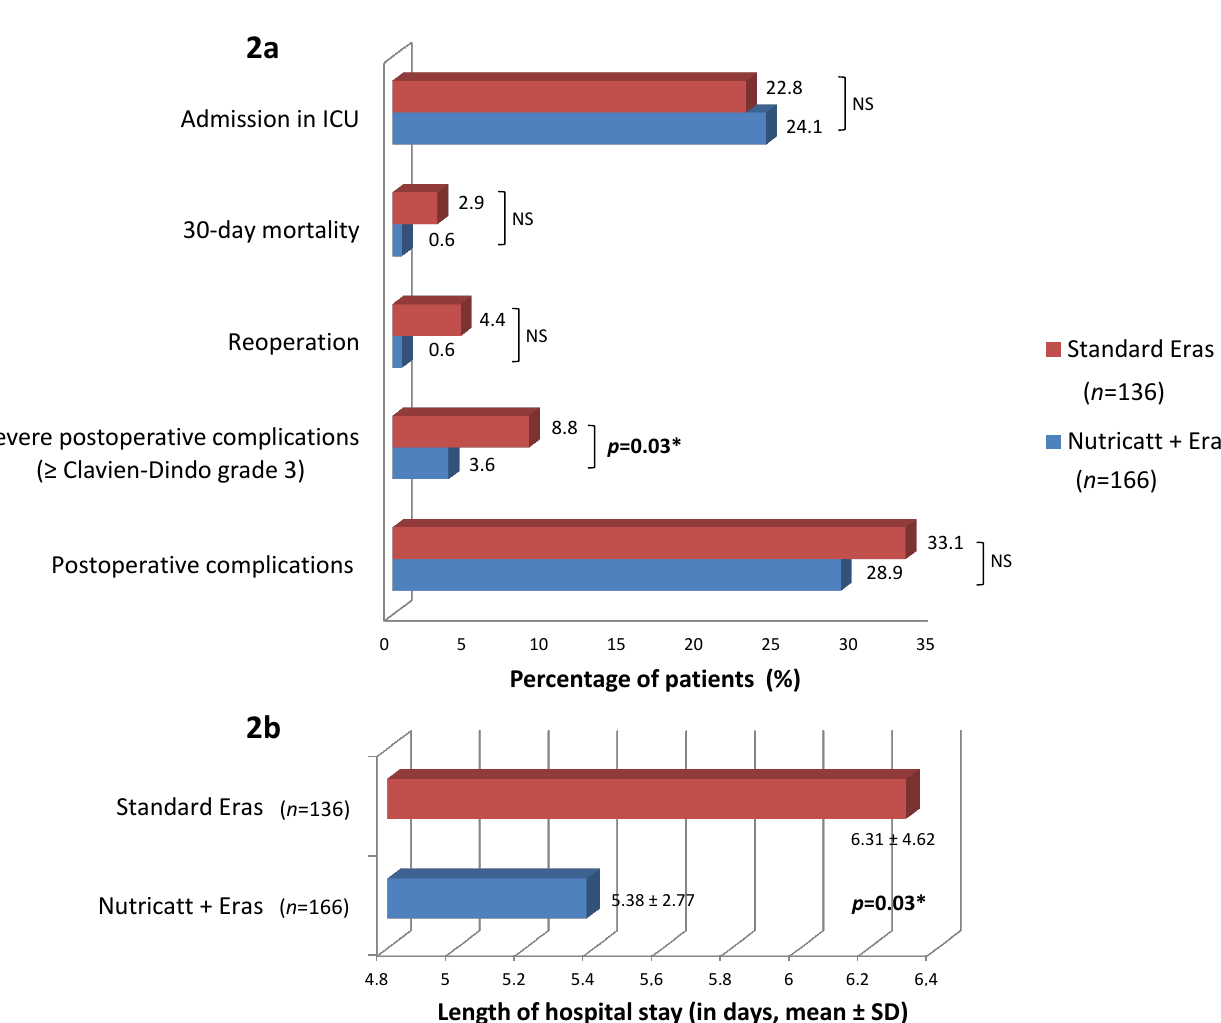
Figure 2. Associations between protocol types and postoperative outcomes ( 2a ) and length of hospital stay ( 2b ). Abbre- viations: Eras, Enhanced Recovery after Surgery; ICU, intensive care unit; NS, non-significant ( p ≥ 0.05); SD, standard deviation. * statistically significant ( p < 0.05).